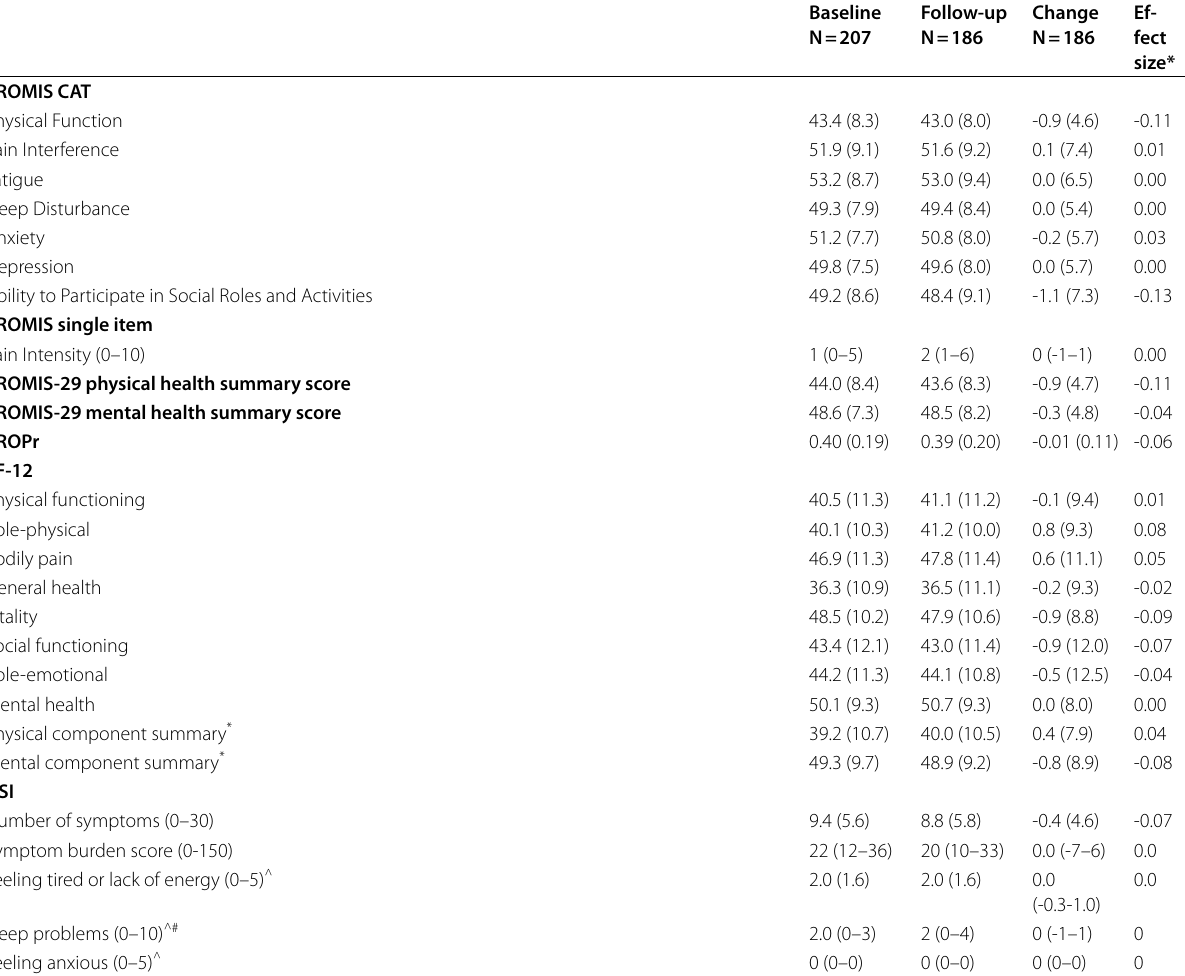
Table 3 Mean(SD) PROM (change) scores at baseline and 6 months follow-up and effect